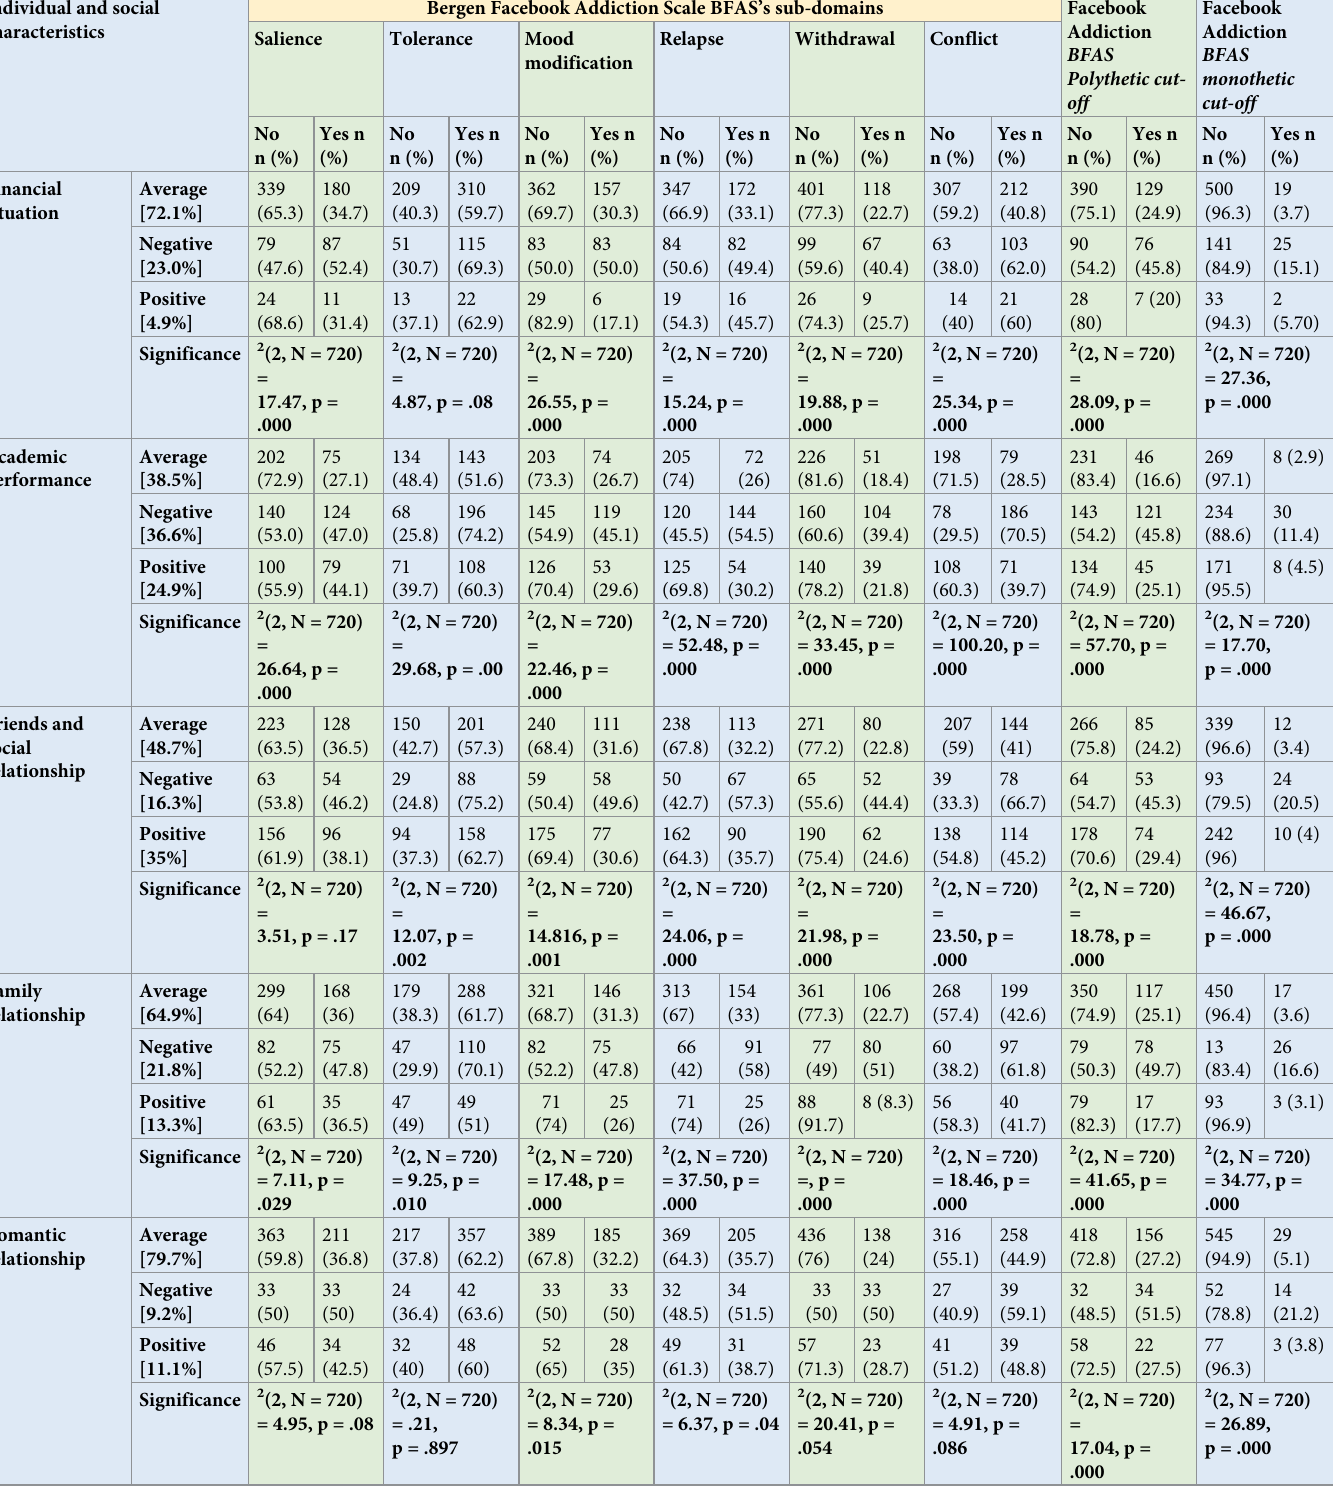
Table 3. Social and individual characteristics related to Facebook addiction (N =